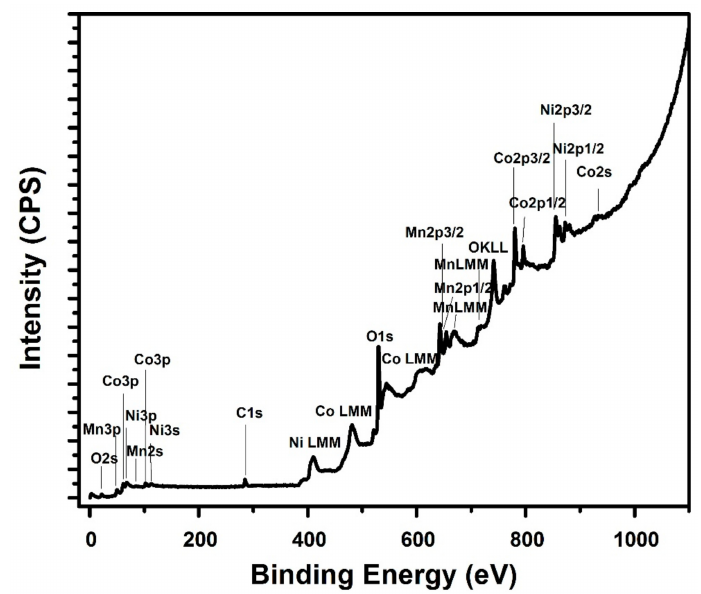
Figure 6. X-ray photoelectron spectroscopy (XPS) survey scan spectra of NiCo 2 O 4 / MnO 2 hierarchical nanostructure on etched Ni